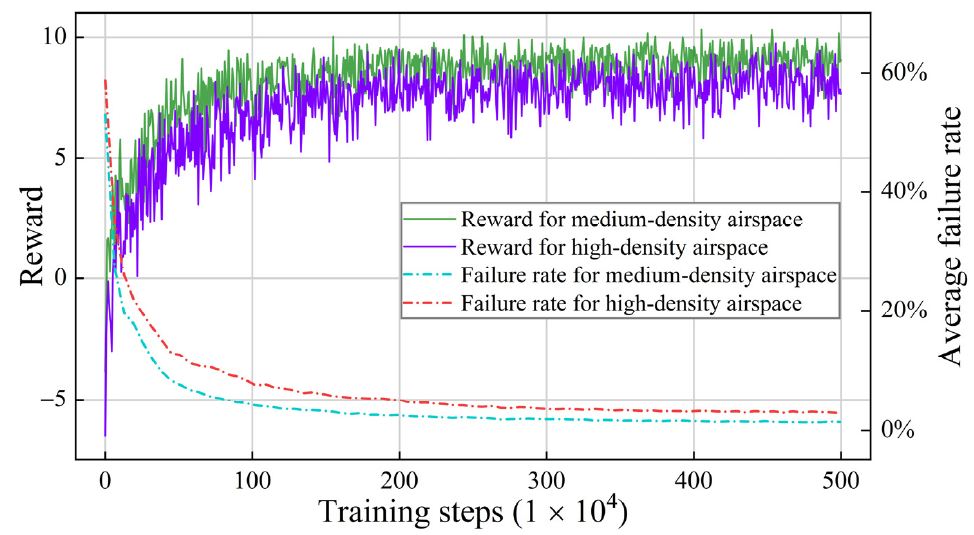
Figure 14. Training data of high-density and medium-density airspace (using